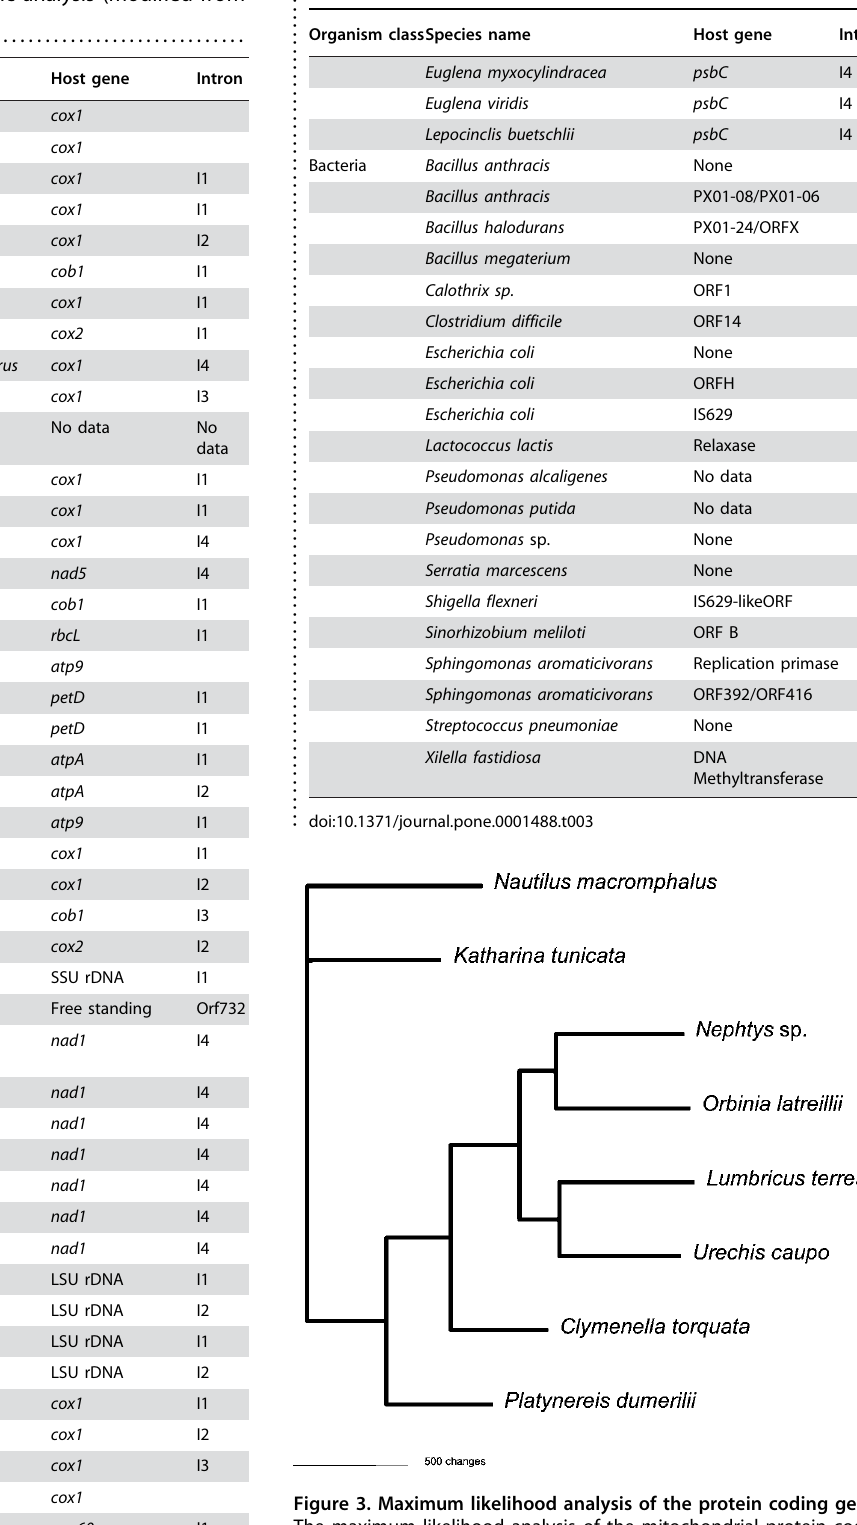
Table 3. Mitochondrial, chloroplast and bacterial group II introns included in the phylogenetic analysis (modified from